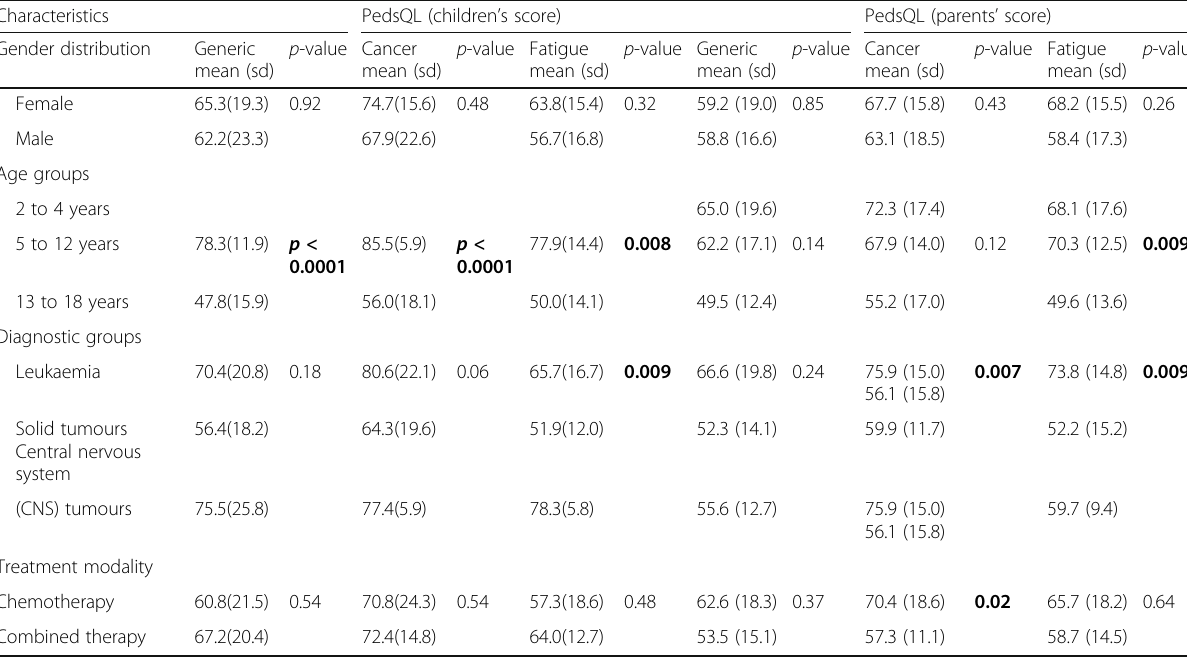
Table 5 PedsQL ™ , children ’ s and parents ’ /proxy self-reports within Sweden